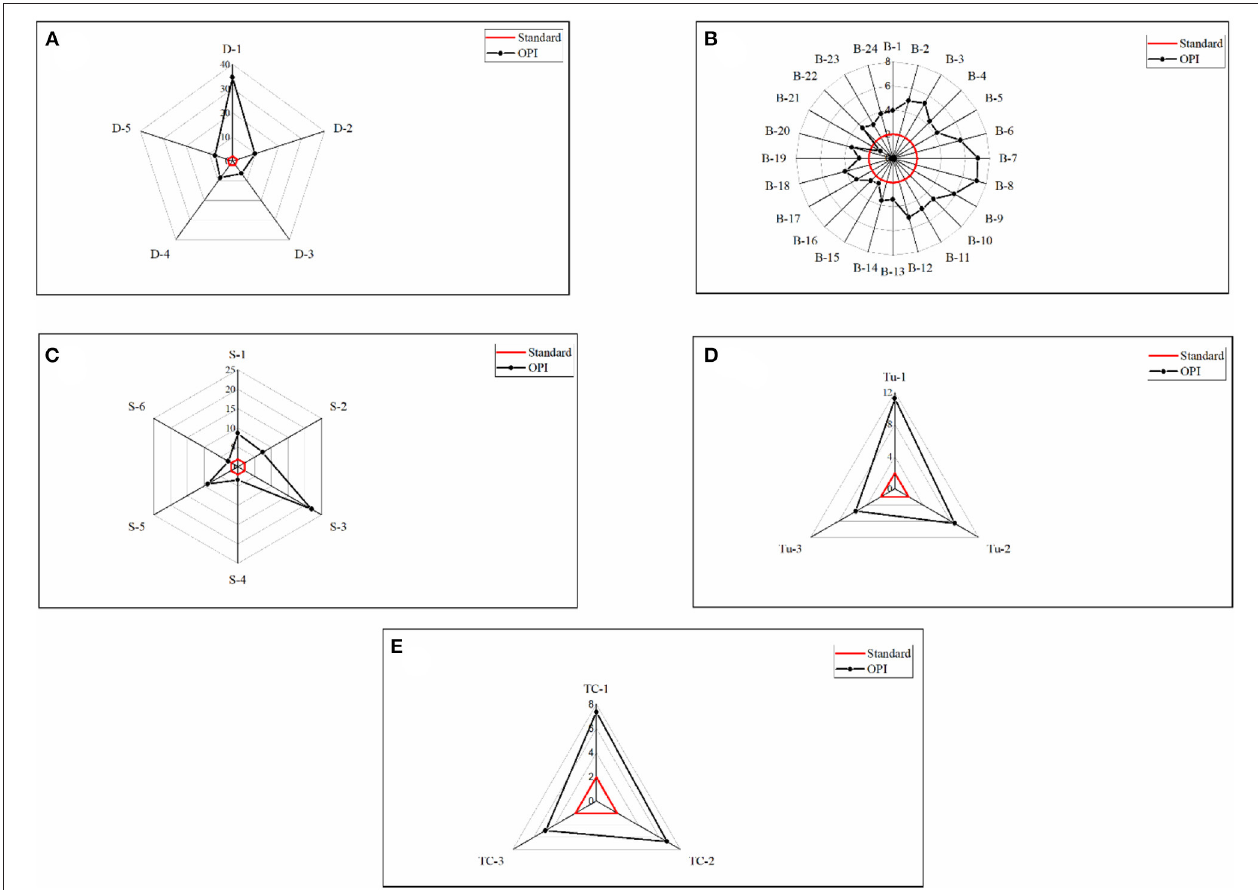
FIGURE 7 | (A–E) Assessment of OPI in the outfalls of (A) Dhaleshwari River, (B) Buriganga River, (C) Shitalakshya River, (D) Tongi Canal, and (E) Turag River (red lines indicate a heavily polluted level of OPI).